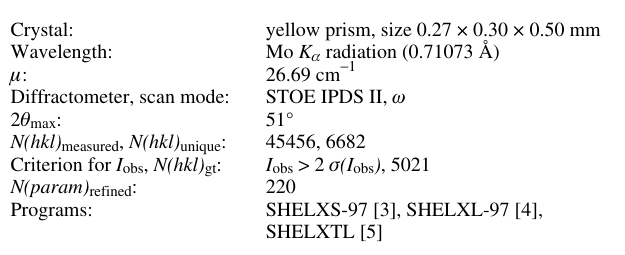
Table 1. Data collection and handling.